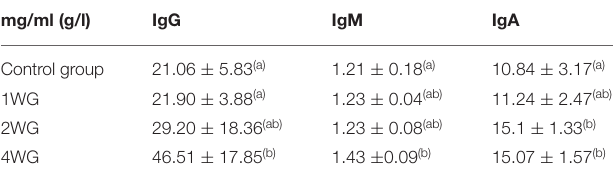
TABLE 3 | Ig concentration in colostrum of bitches enrolled in the 4 study groups.